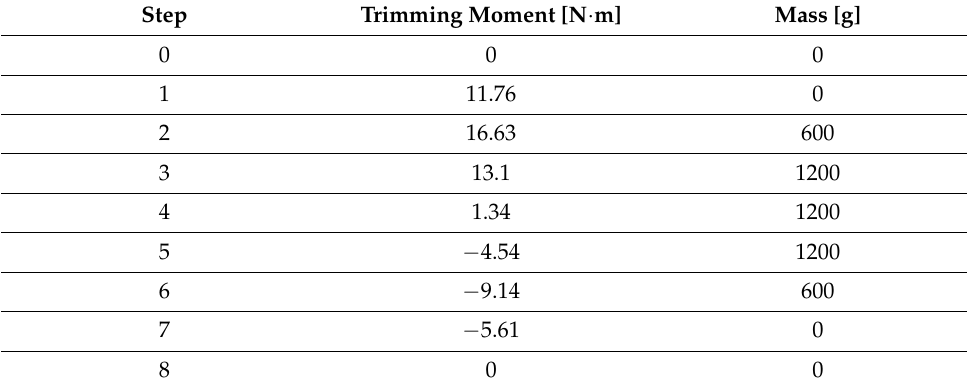
Table 5. Variations of trimming moment and mass in different